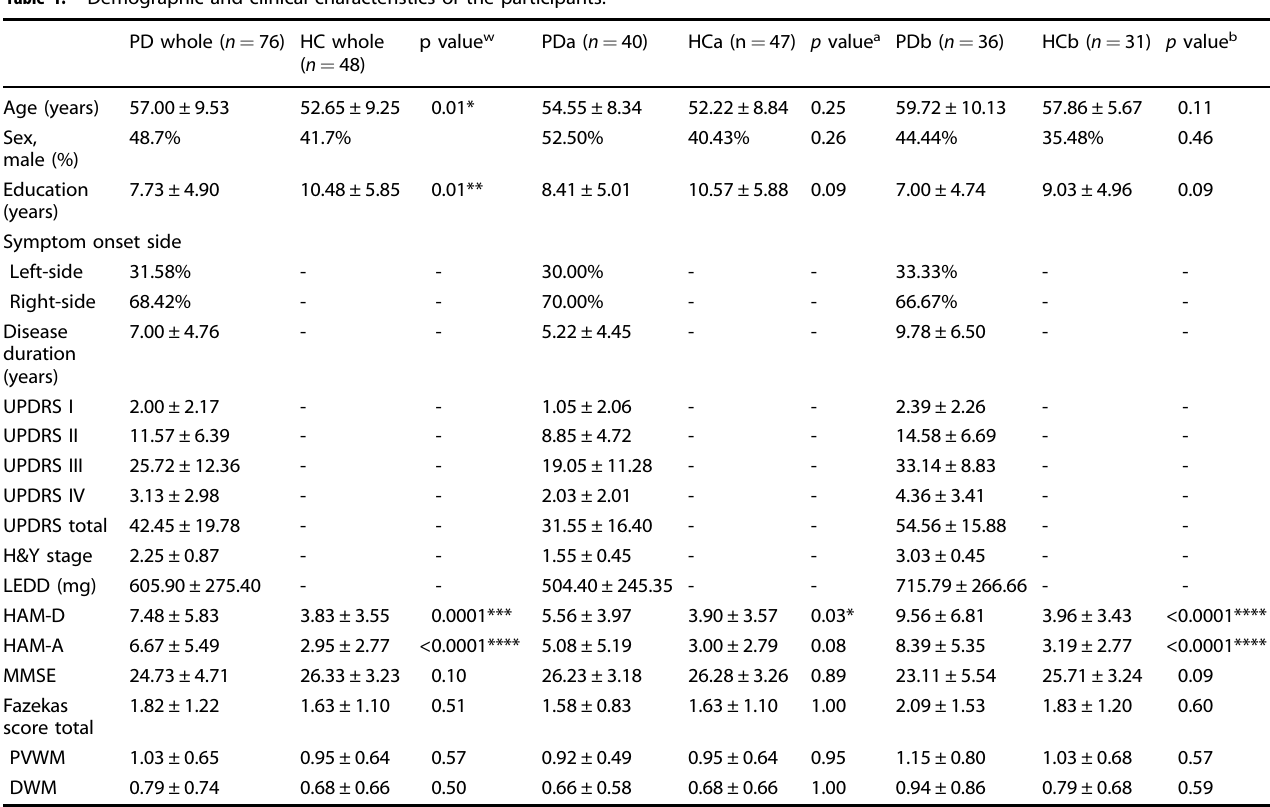
Table 1. Demographic and clinical characteristics of the